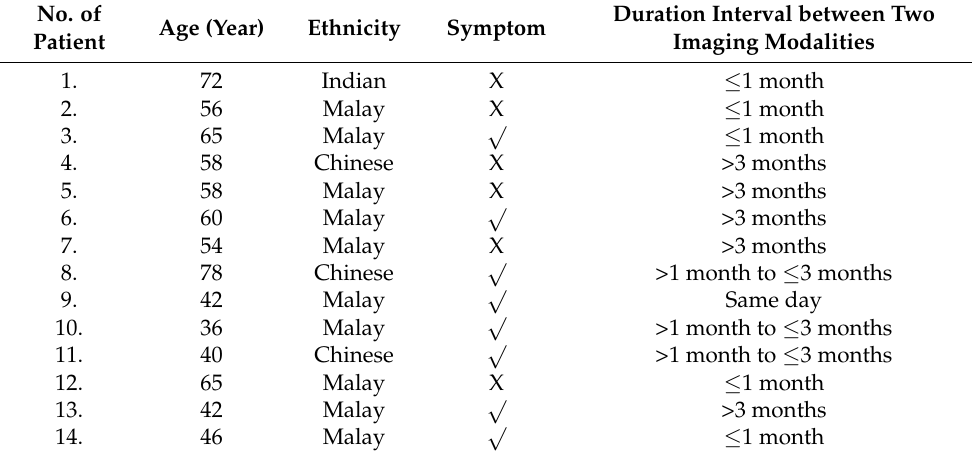
Table 1. Demographic data of patient in our